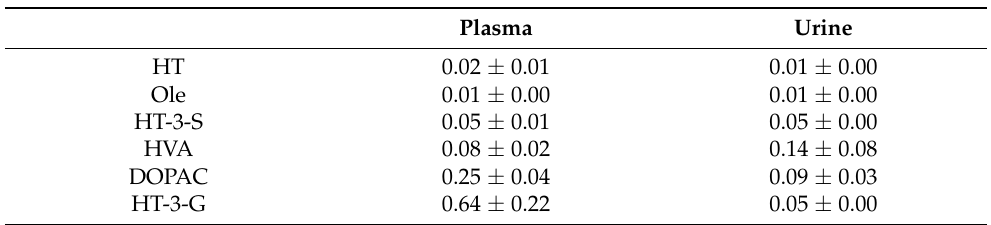
Table 3. Limit of quantification of HT and its metabolites in plasma and urine. Results are expressed as mean (in mg/L) ± SEM.